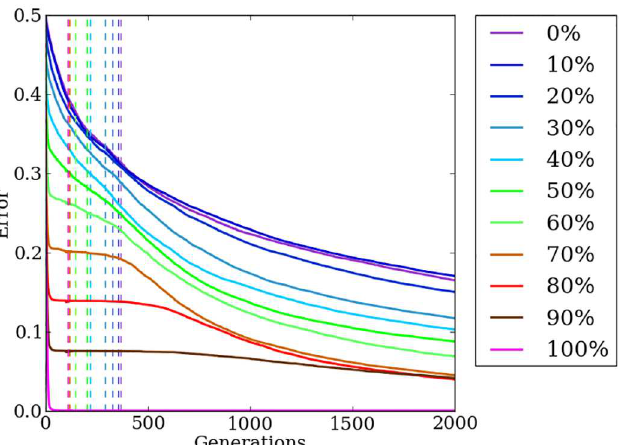
Fig 25. The mean error of Auto-Offset-HybrID generation champions over 2,000 generations on the target weights experiment. The line colors indicatethe regularityof the problemtested. Dashedvertical lines indicate the mean switch point per